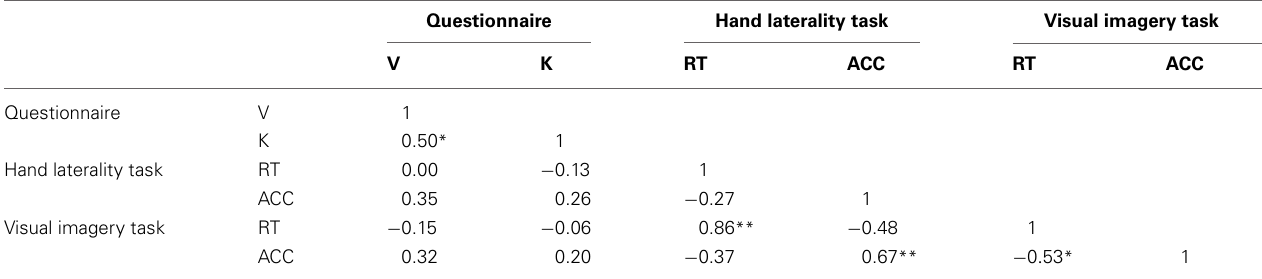
Table 2 | Spearman correlations between the questionnaire, hand laterality task visual imagery task of controls ( N = 16).